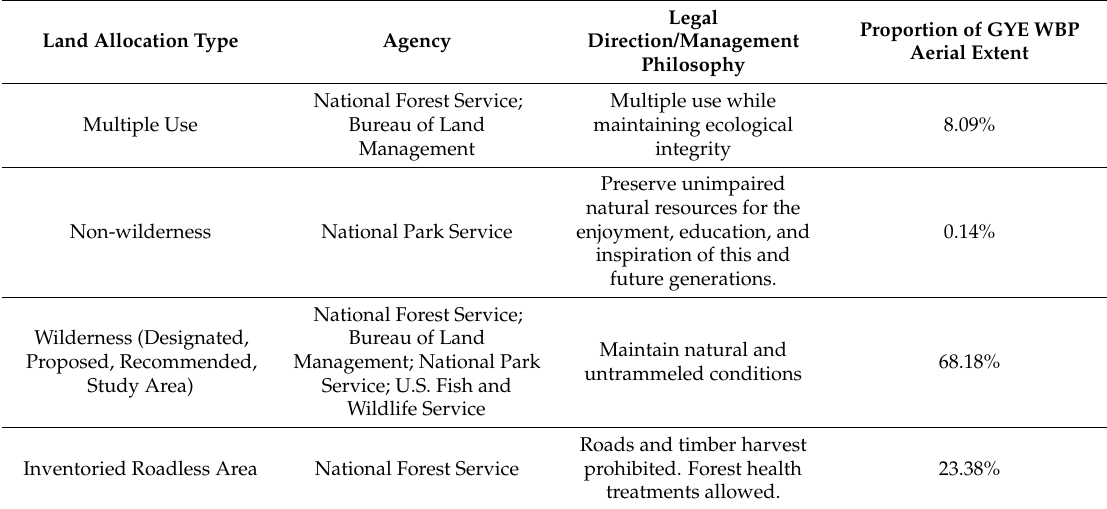
Table 1. Aerial distribution of WBP in GYE by federal land allocation type. Not shown is the 0.21% of the WBP distribution that is on tribal and other land allocation